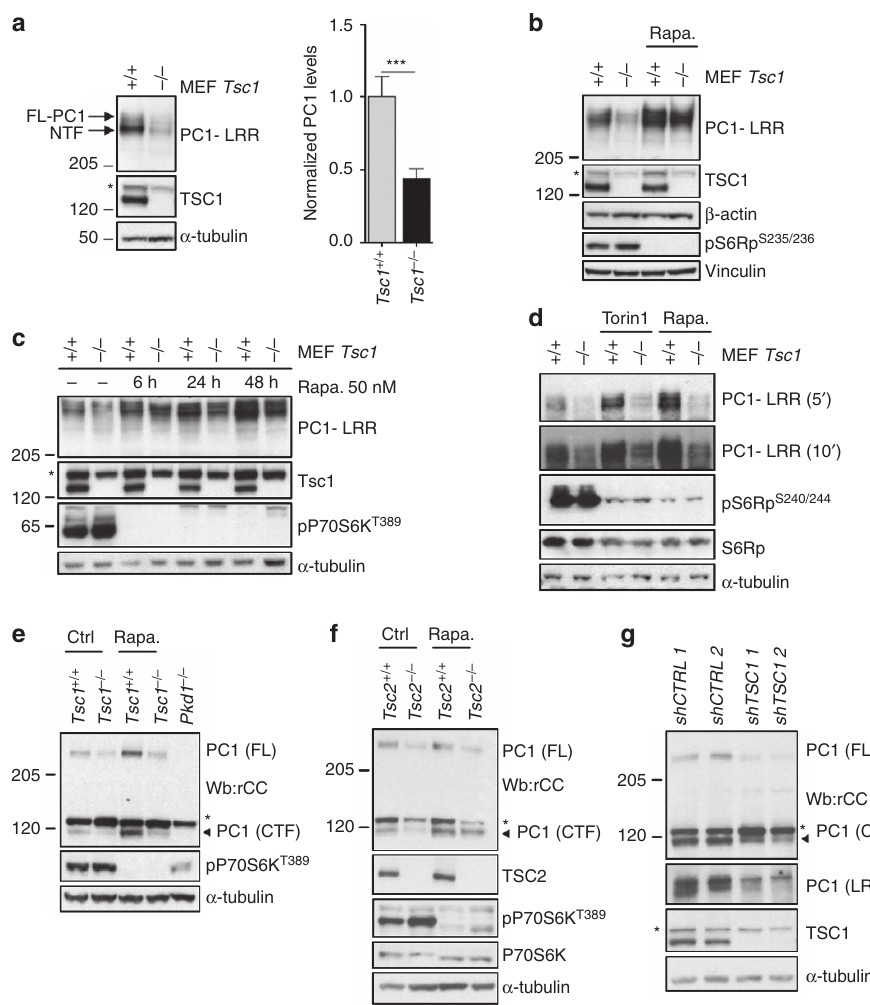
Figure 2 | mTORC1 regulates polycystin-1 expression levels. ( a ) Tsc1 þ / þ and Tsc1 (cid:2) / (cid:2) fibroblasts were immunoblotted for endogenous PC-1. Graph shows quantification of 12 independent experiments. Data are shown as mean ± s.e.m. Statistical analysis was performed using the Student’s unpaired two-tailed t -test. *** P ¼ 0.0009. F-test was used to compare variances. * P ¼ 0.0423. ( b ) Western blot analysis of PC-1 levels in Tsc1 þ / þ and Tsc1 (cid:2) / (cid:2) cells cultured with or without 100nM rapamycin. Data are representative of five independent experiments. *shows a non-specific band. ( c ) Tsc1 þ / þ and Tsc1 (cid:2) / (cid:2) fibroblasts treated with or without 50nM rapamycin for 6, 24 and 48h and immunoblot-detecting PC1. Data are representative of two independent experiments. *shows a non-specific band. ( d ) Tsc1 þ / þ and Tsc1 (cid:2) / (cid:2) cells treated with Torin1 300nM followed by immunoblot of PC1. ( e ) Immunoblot using an anti-C-terminal tail of PC-1 antibody (rCC) 30 in Tsc1 þ / þ and Tsc1 (cid:2) / (cid:2) cells before and after 100nM rapamycin. Arrows indicate the specific bands, * shows a non-specific band. ( f ) Immunoblot using an anti-C-terminal tail of PC-1 antibody (rCC) 30 in Tsc2 þ / þ and Tsc2 (cid:2) / (cid:2) cells before and after 100nM rapamycin. Arrows indicate the specific bands, * shows a non-specific band. ( g ) Immunoblot using an anti-C-terminal tail of PC-1 antibody (rCC) 30 or against the LRR repeats (7e12) in two distinct clones of mIMCD3 cells infected with a shRNA directed against the Tsc1 gene (shTSC1-1 and -2) or control shRNA sequences (shCTRL-1 and -2), * shows a non-specific